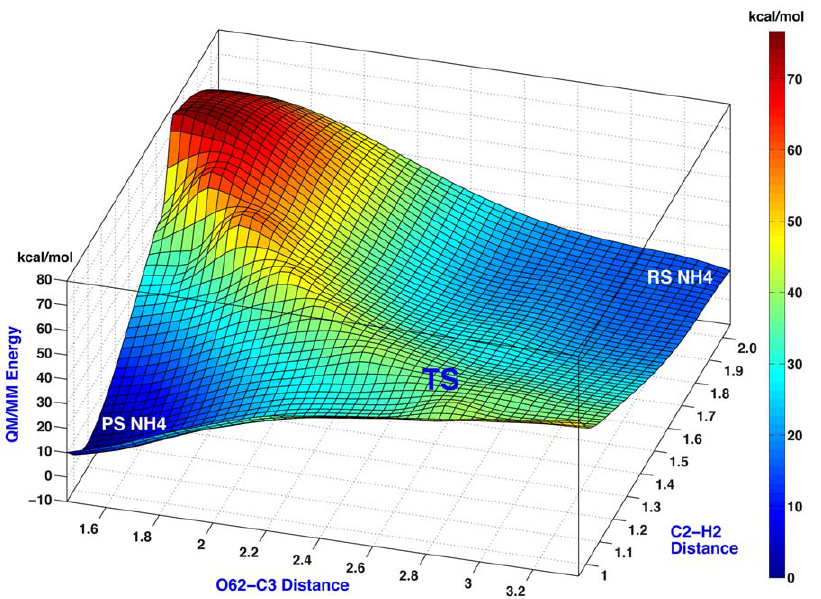
Figure 3. PES of the non-enzymatic formation of the bicyclic derivative of biapenem when N4 is protonated. The PES is defined by two reaction coordinates: the forming C2–H2 bond between the hydroxyl hydrogen and C2 and the forming C3–O62 bond between the hydroxyl oxygen and C3. The position of the only TS is marked on the surface. QM/MM energies are in kcal/mol. Colors on the PESs reflect the QM/MM energy levels, as represented in the reference bar on the side.